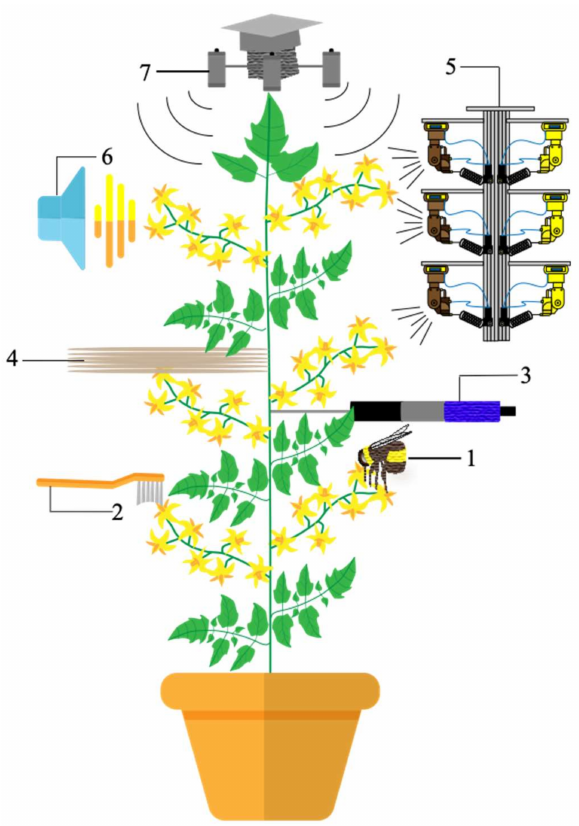
Figure 7. Stylised image showing different pollination techniques utilised in the tomato protected- cropping industry: (1) Natural buzz by bees can effectively pollinate multiple tomato flowers within a protected environment; (2) The electric toothbrush can mechanically stimulate individual flowers making it effective for cross-pollination breeding programs; (3) A tuning fork or wand placed below the floral truss can vibrate the entire truss leading to efficient pollination; (4) Wooden sticks tapped onto trellis strings multiple times will force plant vibrations leading to effective pollination of many trusses and flowers; (5) Commercial robotic devices have been engineered to eject pulses of air that mechanically shake the floral truss leading to targeted pollination of flowers in a high throughput manner; (6) Acoustic speakers could be commercially developed to emit sonic waves that accelerate floral movement without physical contact and trigger successful pollination of an entire floral truss; (7) Robotic drone technology has been developed to force mechanical air movement of specific intensity above the crop leading to pollination of upper floral trusses. Table 2. Relative costs of commercial pollination techniques in Australia. The degree of human involvement required to operate the pollination technique is strongly linked to cost, with more involvement increasing cost. Previous costs associated with insect pollination [82], electric toothbrush and buzz probe [6], and trellis trapping (AUD 26/h: 3 h × 3 days/week × 46 weeks) are estimates only for comparison purposes.